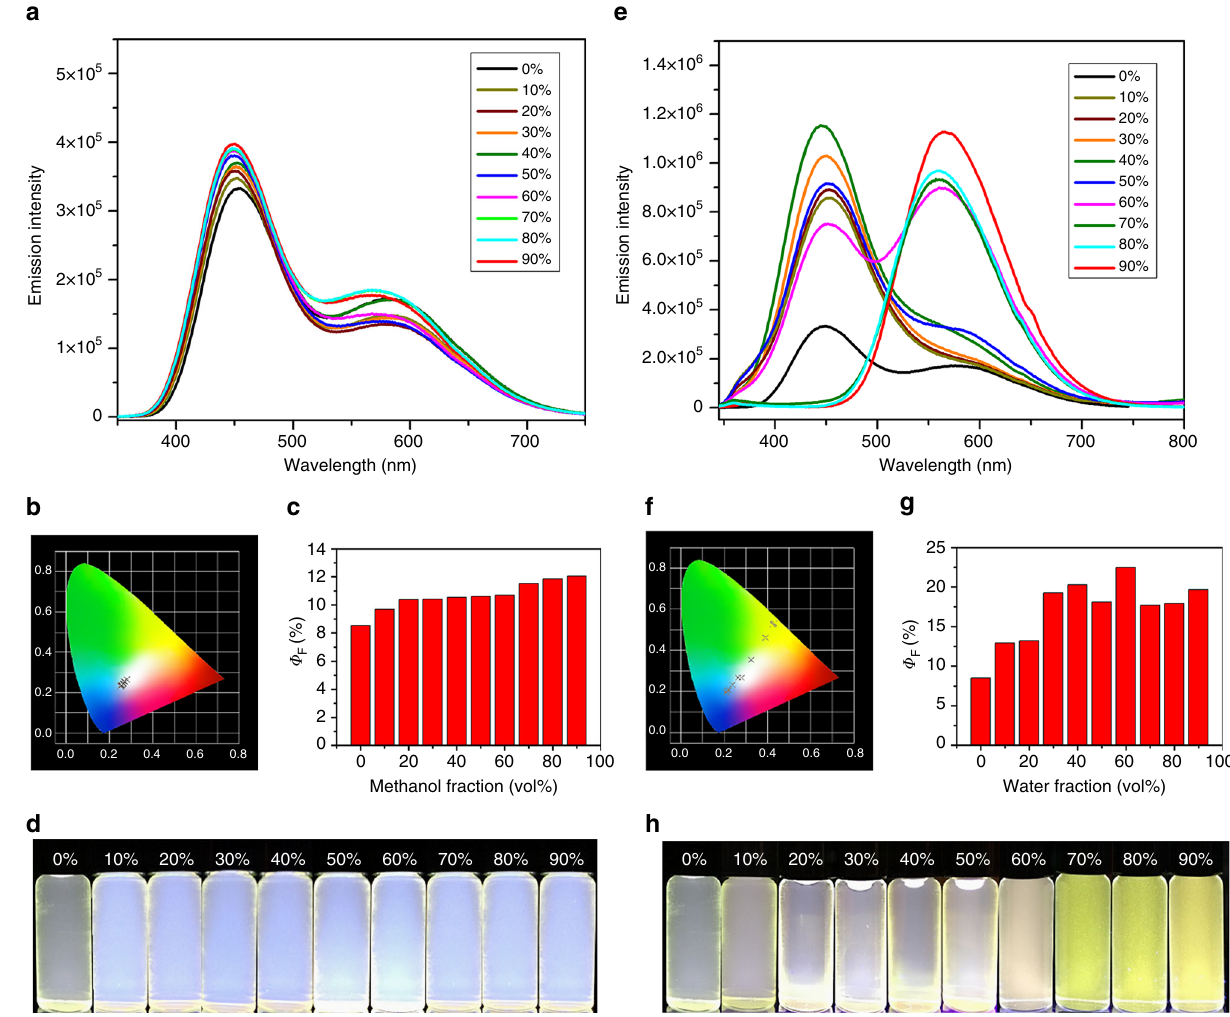
Fig. 5 AIE of G2 . a Fluorescence spectra ( λ ex = 320 nm, c = 1.0 µ M), b CIE 1931 chromaticity diagram, (the crosses signify the luminescent color coordinates), c quantum yields, and d photographs of G2 in CH 3 CN/methanol with various methanol fractions; e fl uorescence spectra ( λ ex = 320 nm, c = 1.0 µ M), f CIE 1931 chromaticity diagram, g quantum yields, and h photographs of G2 in CH 3 CN/water with various water fractions. G2 samples were excitation at 365 nm on 298 K ( c = 1.0 μ